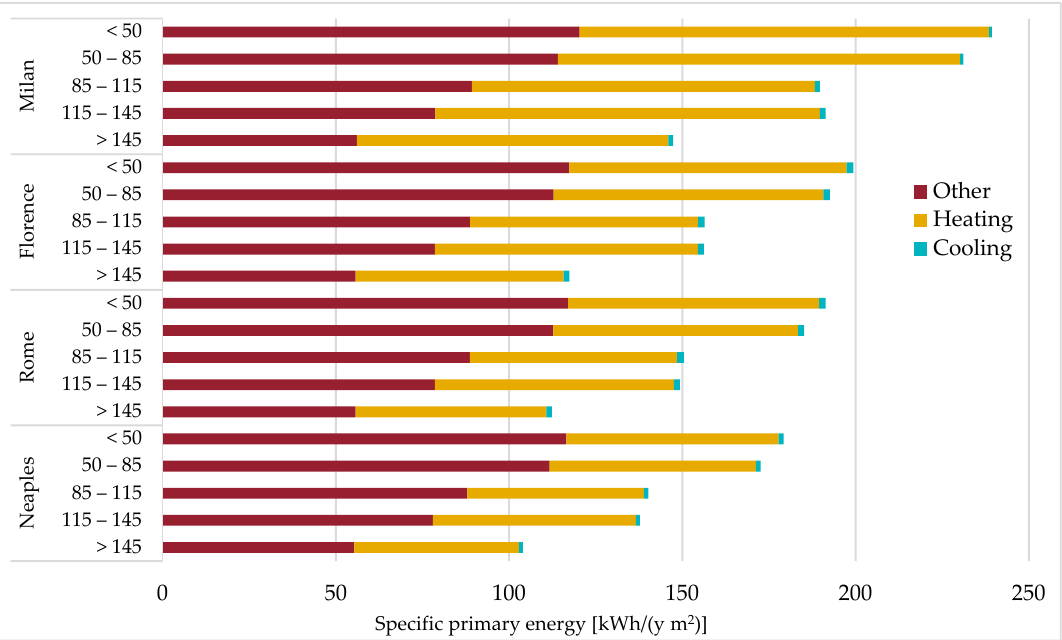
Figure 8. Specific consumption of primary energy for other services.